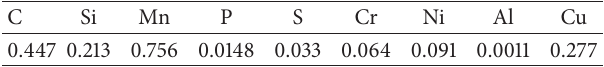
Table 1: Chemical composition of SAE 1045 (wt%) [3].